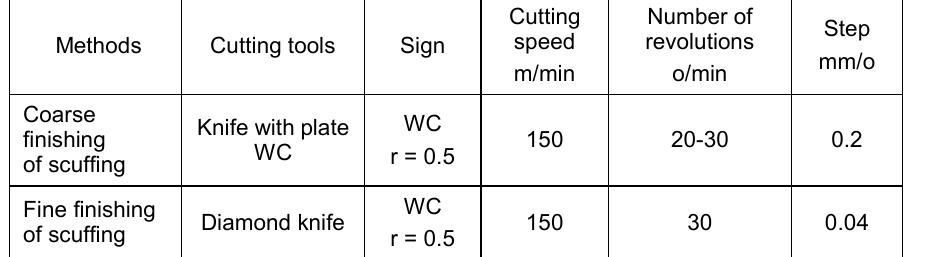
Table 4 – Parameters of machining the AlSi12 - polyester